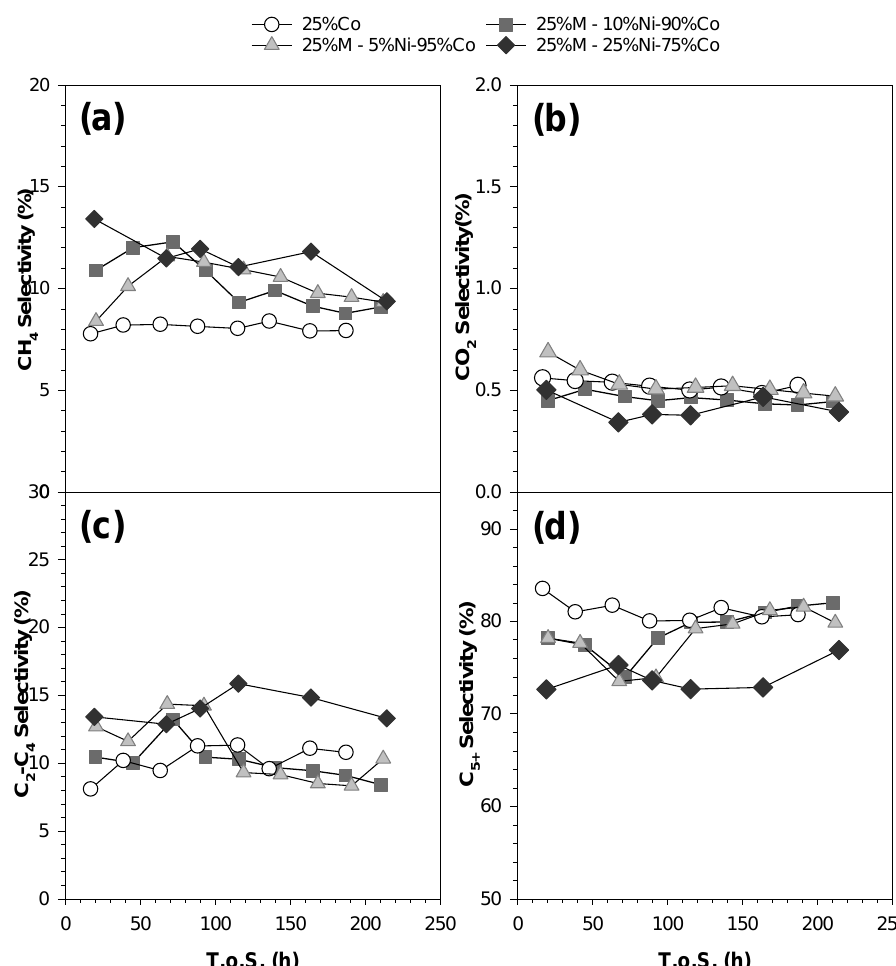
Figure 21. Evolution with T.o.S. of ( a ) CH 4 , ( b ) CO 2 , ( c ) C 2 –C 4 , ( d ) and C 5 + selectivities for the prepared catalysts (process conditions: P = 20.6 bar, H 2 / CO = 2 mol / mol, T = 220 ◦ C, S.V. = 3.4 slph per g cat ).